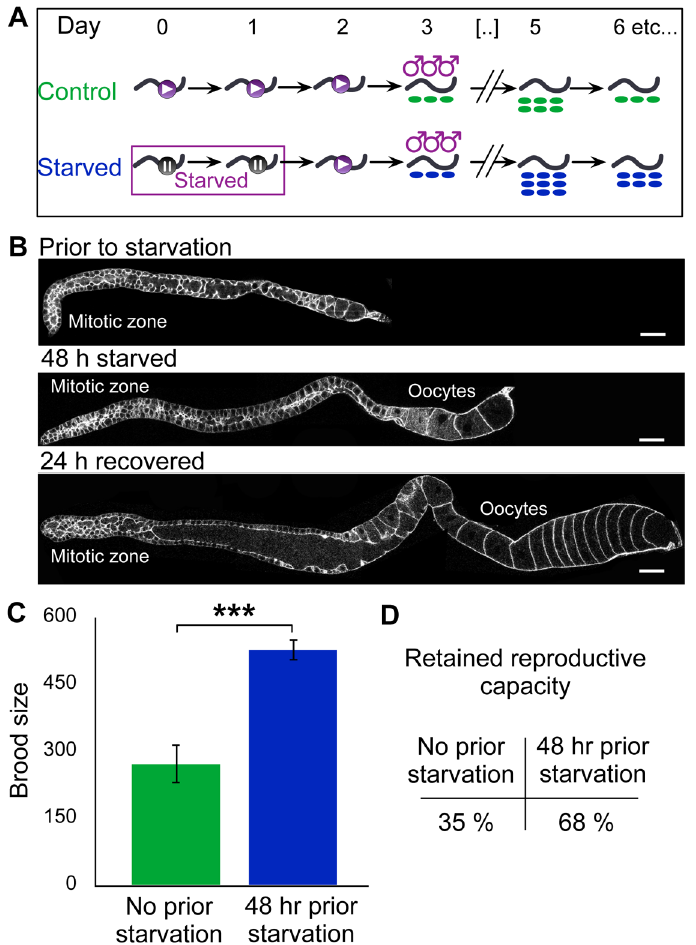
Fig 2. Starvation delays reproductive senescence. (A) Schematic of starvation experiment. (B) Phalloidin- stained fog-2 gonads before and after starvation. Scale bar: 25 μ m. (C) Total brood size for fog-2 females mated after 2 days of starvation or control treatment. For statistical tests see S2C Table. (D) Reproductive capacity retained by fog-2 females after 2-day starvation or control treatment (computed by dividing numbers used in C by reproductive capacity at day 0). Error bars represent 83% confidence intervals; asterisks indicate significance of Wilcoxon rank sum test